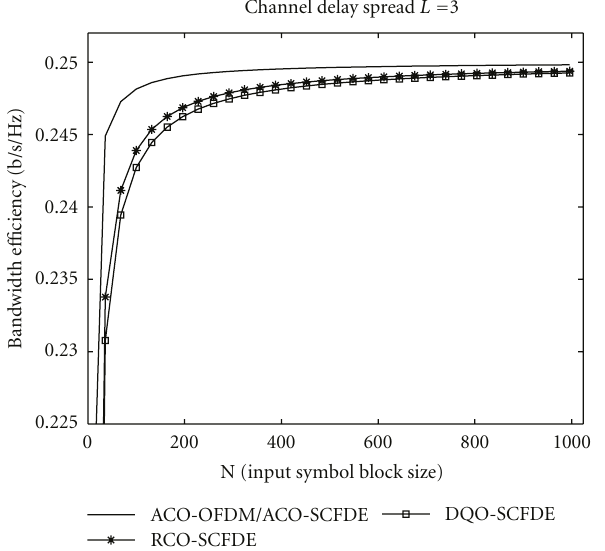
Figure 10: Computational comparison for ACO-OFDM, RCO- SCFDE, and DQO-SCFDE.